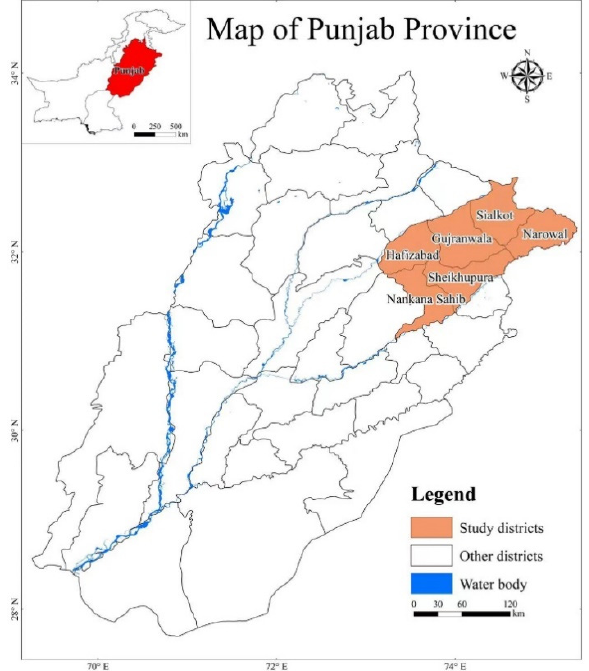
Figure 1. Map of the selected districts.